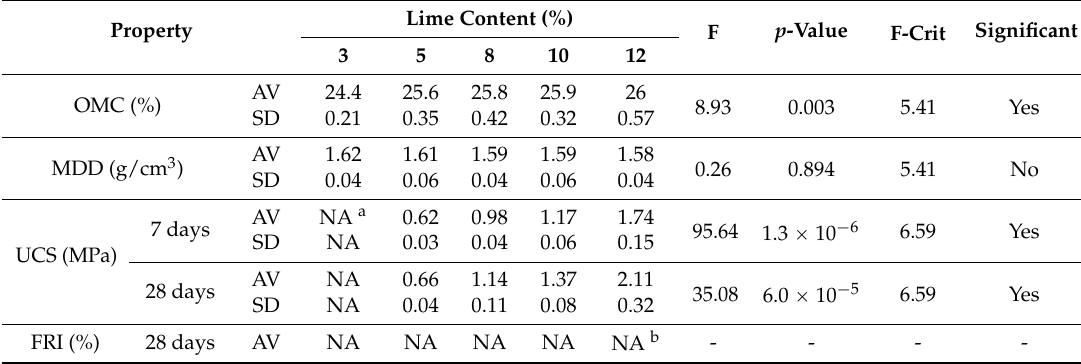
Table 5. Results of lime-stabilized boron waste (LSB) ( α =